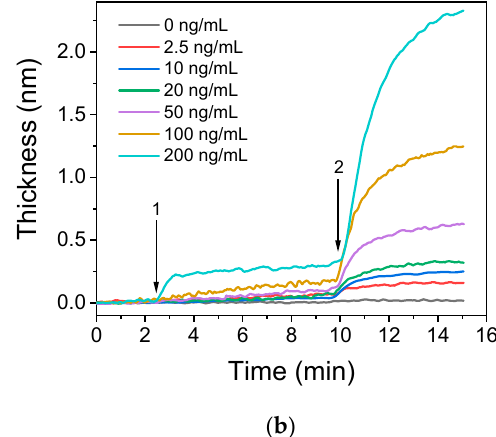
Figure 3. ( a ) Sensor responses obtained upon running a 100 ng/mL CRP calibrator for 5 to 30 min followed by 5-min reaction with a 10 µ g/mL anti-CRP detection antibody solution. Each point is the mean value of three measurements ± SD. ( b ) Real-time responses obtained upon running over the chip for 7 min CRP calibrators with concentration ranging from 2.5 to 200 ng/mL (arrow 1 to 2) followed by a 10 μ g/mL anti-CRP antibody solution for 5 min (arrow 2 to end of run). The calibration curve obtained using the 12-min immunoassay protocol (15 min includ- ing the 3 min baseline equilibration with assay buffer at the start of each run) is presented in Figure 4. The linear regression equation of the calibration curve was: Sensor response = 0.01 ( ± 0.001) concentration + 0.11 ( ± 0.01), and the correlation coefficient was R 2 = 0.9996. The detection limit (LOD) of the assay was calculated as the concentration corresponding to +3SD of 10 replicate measurements of zero calibrator and was 1.0 ng/mL. Respectively, the limit of quantification (LOQ) was calculated as the concentration corresponding to +6SD of 10 replicate measurements of zero calibrator, and was 2.5